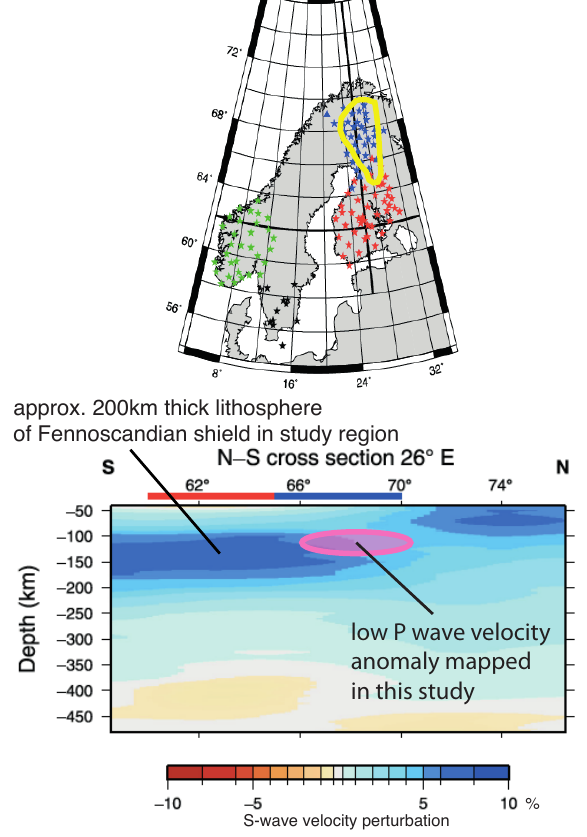
Figure 12. Comparison to previous lithosphere thickness results. The figure has been modified from Pedersen et al. (2013) and it shows the S wave velocity structure obtained in that study in com- parison to the global S wave velocity model by Debayle and Ri- card (2012). The area outlined with the yellow line shows the well- resolved part of our model at the depth of the low-velocity anomaly found in the upper mantle.